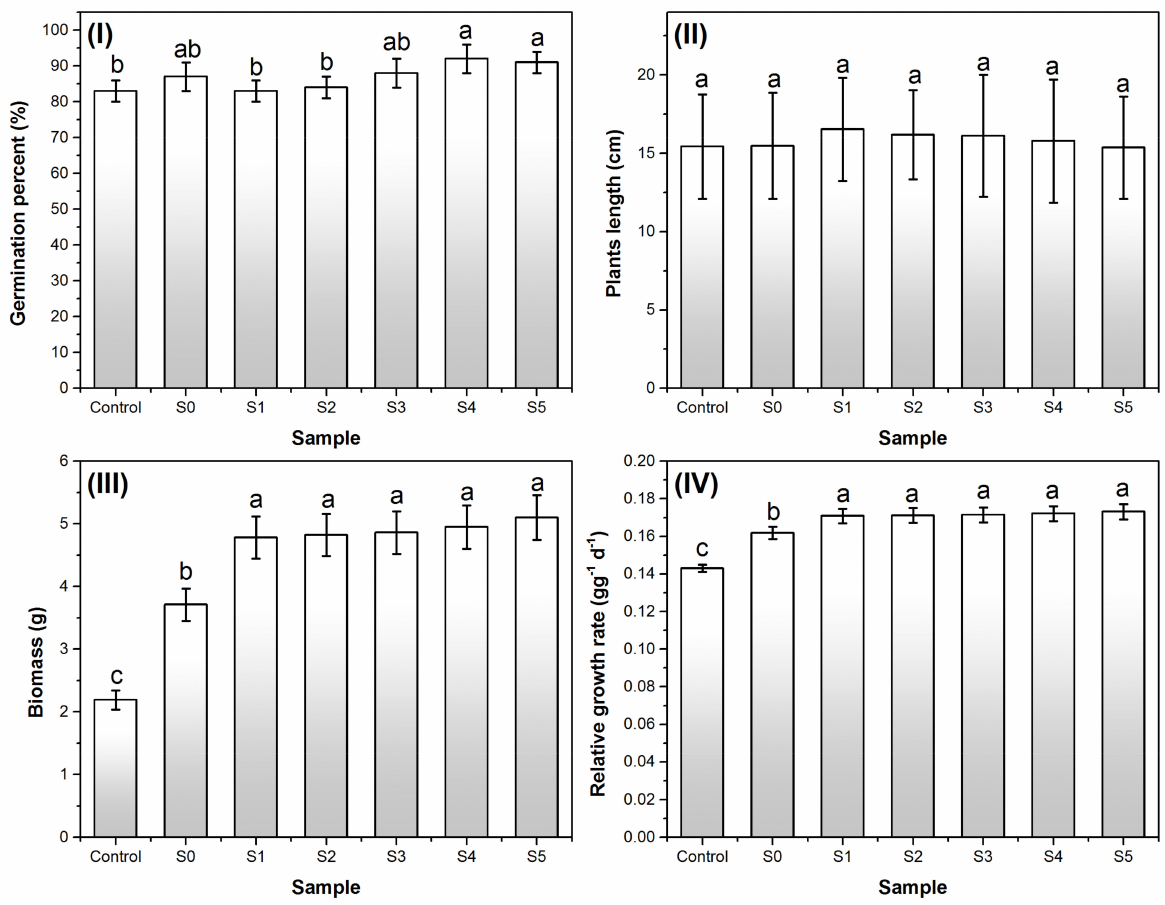
Figure 6. The main specific parameters of plants growth: ( I ) germination percent; ( II ) plant average length; ( III ) biomass; ( IV ) relative growth rate. Values are expressed as means of three replicates and error bars represent the standard deviation. Columns denoted by different letters indicated significant ( p < 0.01) differences among different agriglass